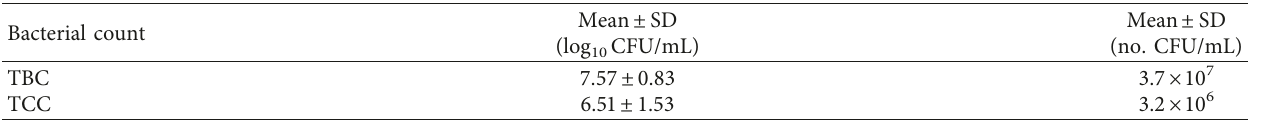
Table 4: Total bacteria and coliform counts in raw milk from Gomole district, Borena zone, South Ethiopia, 2019. Bacterial